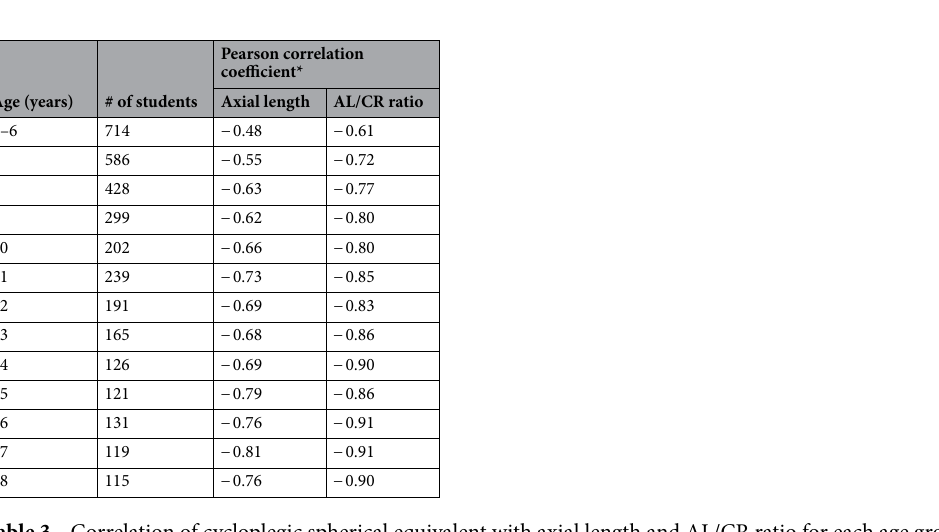
Table 3. Correlation of cycloplegic spherical equivalent with axial length and AL/CR ratio for each age group. AL/CR ratio axial length/corneal curvature radius ratio. *All the Pearson Spearman correlation coefficients are statistically significant.